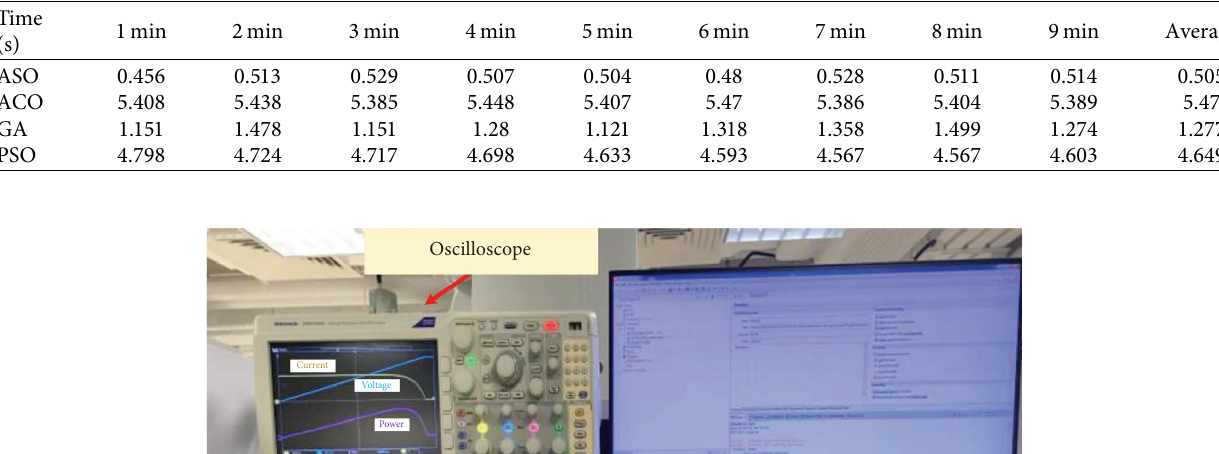
Table 4: Te simulation time (s) of diferent reconfguration methods.